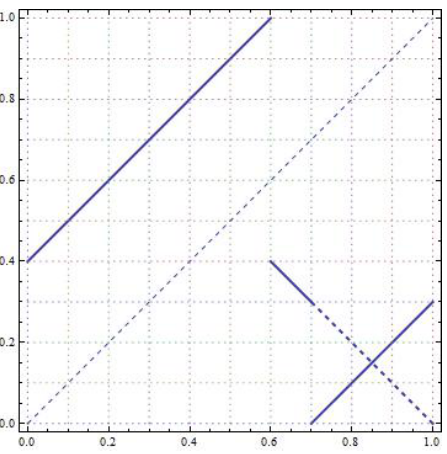
Figure 16. The graph of the ( 3,1 ) -IET T with permutation ( 3, − 2,1 ) and λ = ( 0.6,0.1,0.3 ) (solid lines). The thick solid lines correspond to the ( 2,1 ) -IET which can be derived from T